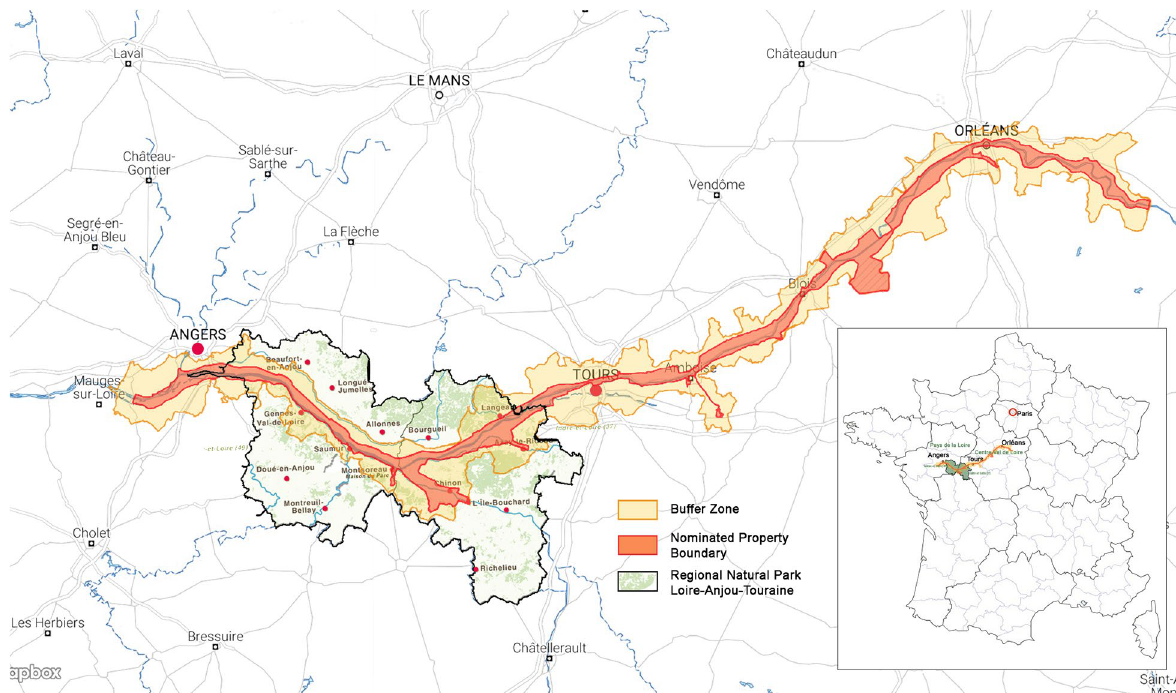
Fig. 2 Location and delimitation of the World Heritage Cultural Landscapes Loire Valley. (Source: Peng 2020). References of delimitation: documents of Loire Valley of World Heritage, World Heritage Center-UNESCO; map of Park, Regional natural park Loire-Anjou-Touraine. Background map: